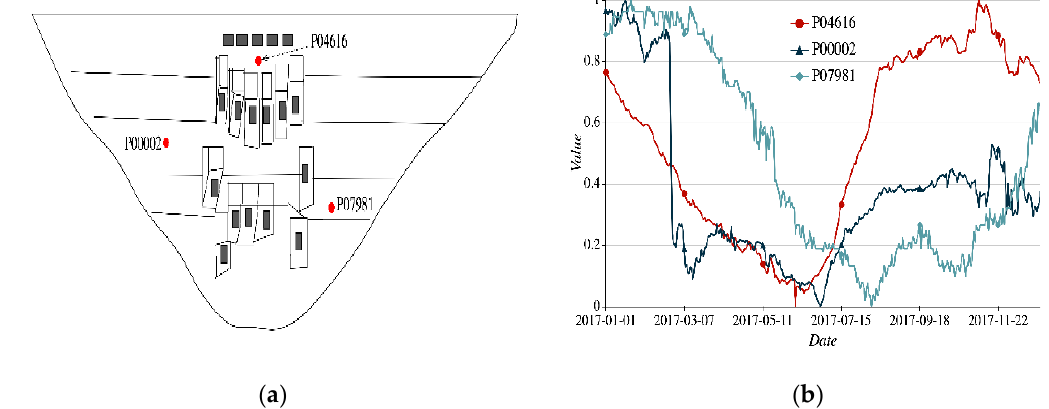
Figure 4. Spatial-temporal feature of nodes P04616, P07981, and P00002 ( a ) spatial distribution of three nodes; ( b ) sequential process lines of three nodes. nodes; ( b ) sequential process lines of three